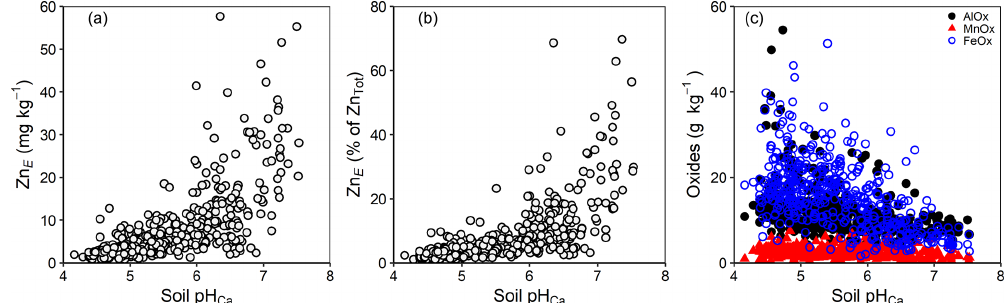
Figure 5. Concentration of (a) Zn E in soil, (b) Zn E as a percent of Zn Tot and (c) mineral oxides in soil as a function of soil pH Ca